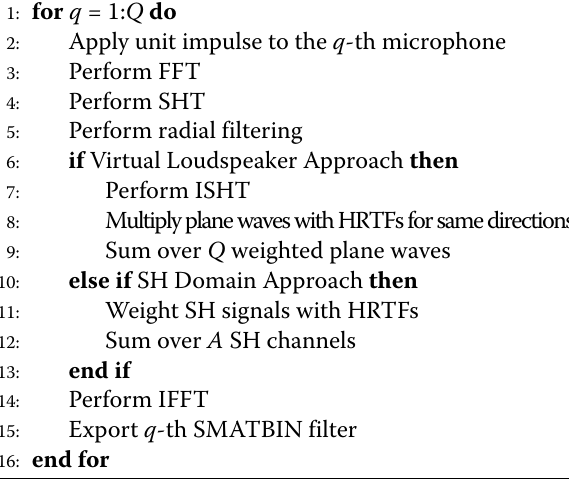
Algorithm 1 Pseudocode for generating the SMATBIN filters for one head orientation using either the